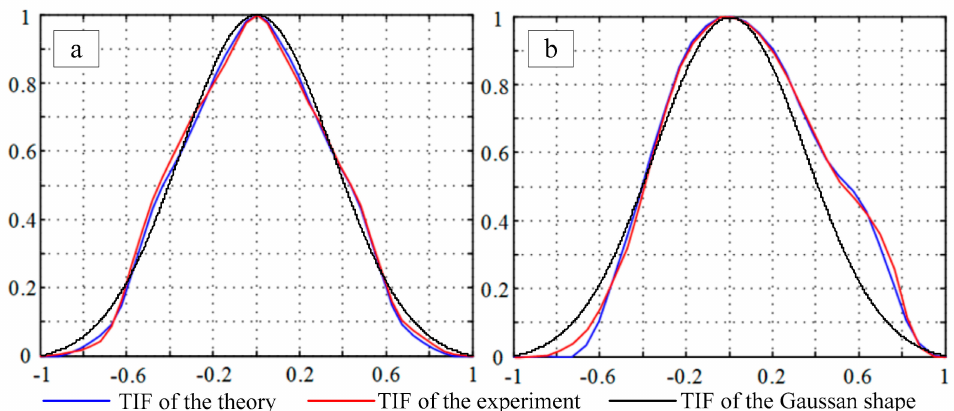
Figure 7. TIFs of the theory and experiment. ( a ) Section profile in the x-direction, ( b ) section profile in the y-direction.